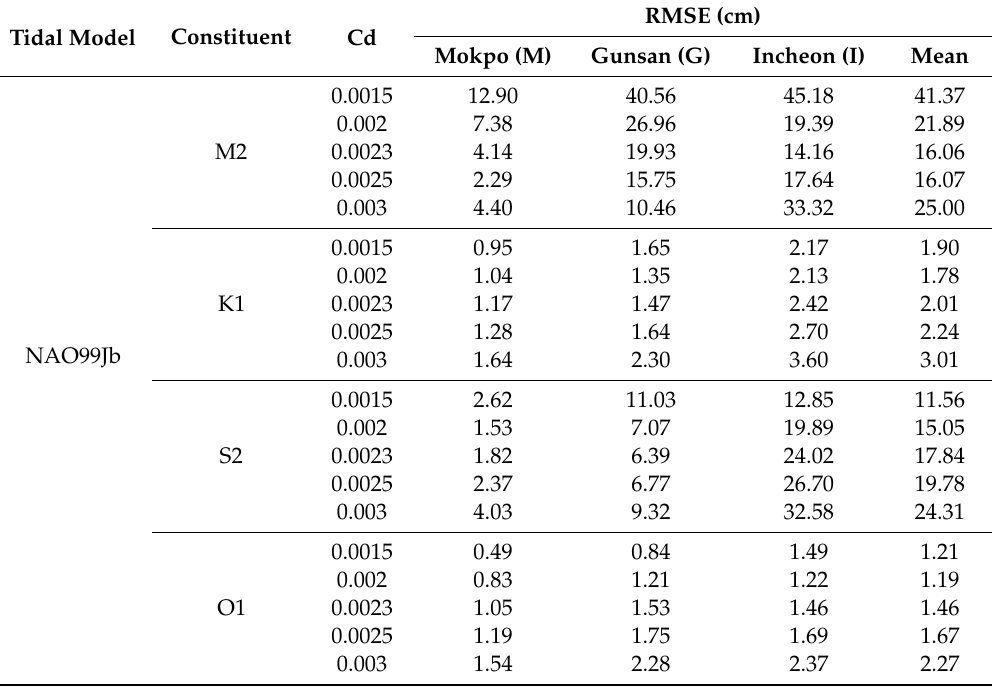
Table A3. RMSE results obtained from uniform roughness bottom for NAO99Jb. Tidal